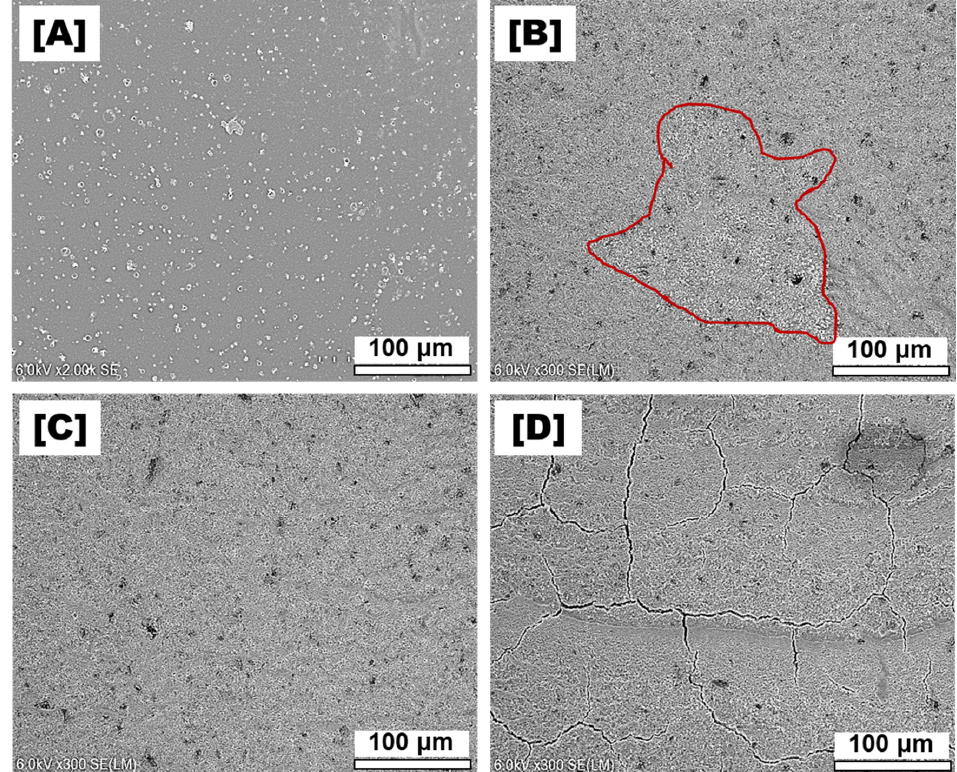
Figure 3. SEM images of the ( A ) pristine nanofiltration (NF) membrane, and the composite membranes with UiO ‐ 66_GO loadings of ( B ) 5%, ( C ) 10%, and ( D ) 15%.